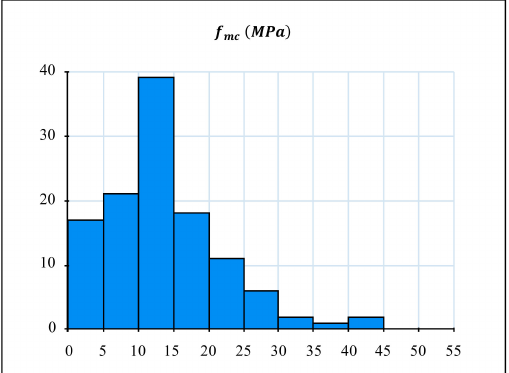
Figure 3. Distribution of the targeted parameter.